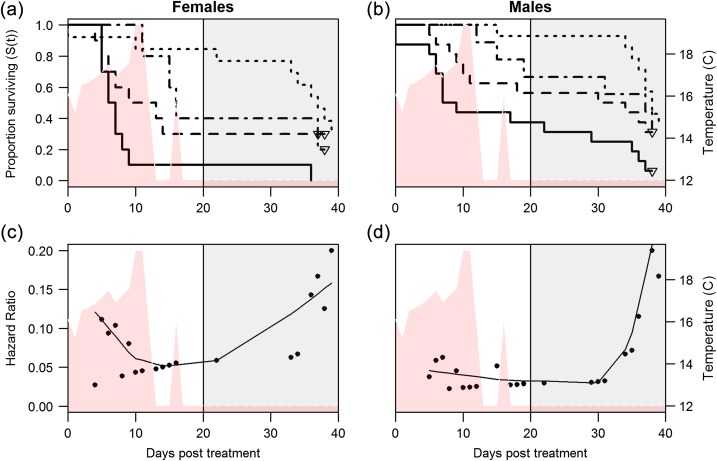
Kaplan–Meier survival curves are shown for female (a) and male (b) Early Stuart sockeye exposed to severe gillnet entanglement (20 min plus 1 min air exposure, n = 26; solid), mild gillnet entanglement (20 s plus 1 min air, n = 26; dashed), biopsied controls (n = 14; dot-dashed) and non-biopsied controls (n = 27; dotted). Triangles are censored data points. The grey shaded area corresponds to the spawning period of this population including nest defence. The red shaded area shows the temperature (°C) of all holding tanks through course of the study, which follows the modelled thermal experience of an Early Stuart sockeye migrant in the Fraser River in 2014. Daily hazard ratios for females (c) and males (d) are plotted as a function of time (all treatments combined) with a solid line lowess smoothing function. Hazard ratios correspond to the number of mortalities divided by the total survivors on each day the mortality occurred.